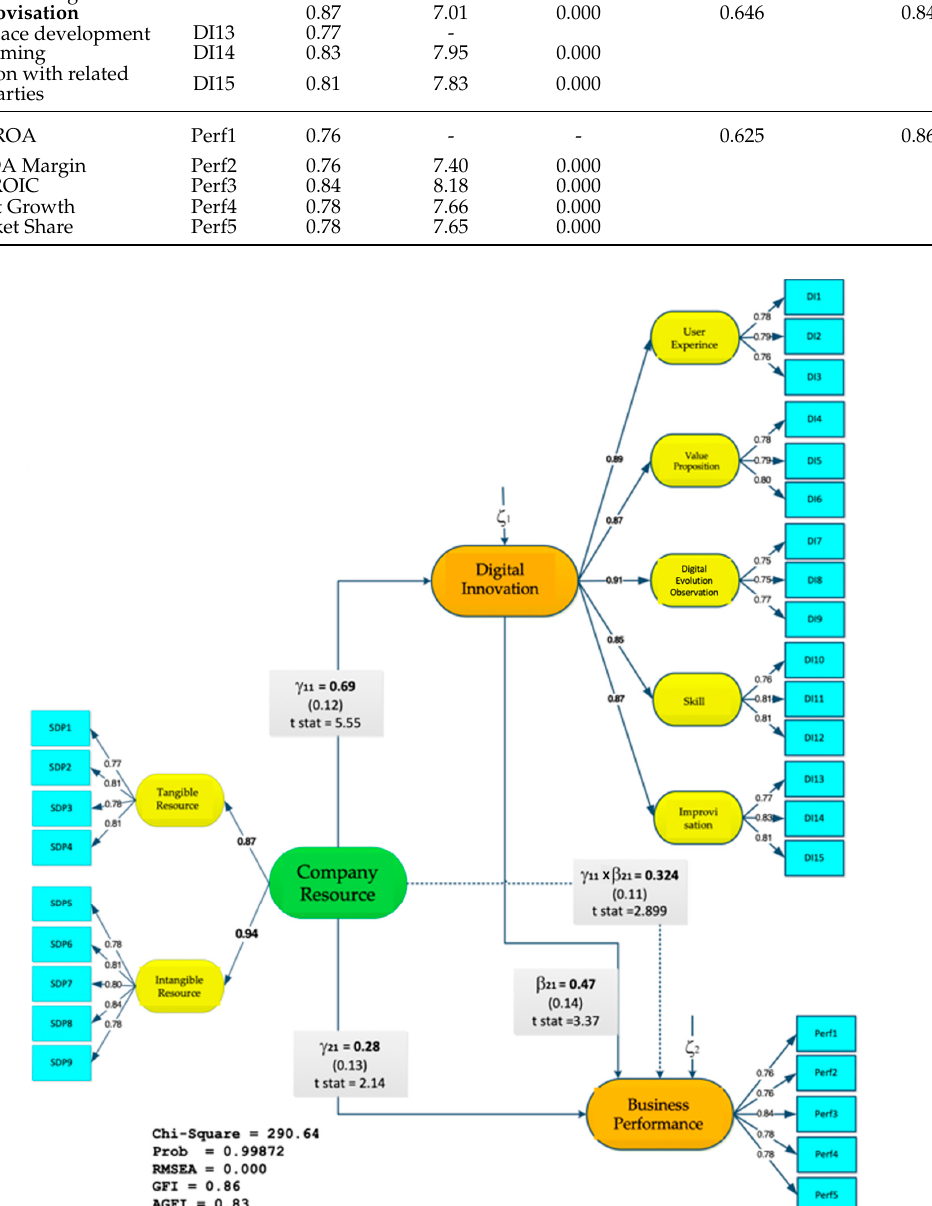
Figure 3. The Model Result. Source: Researcher.